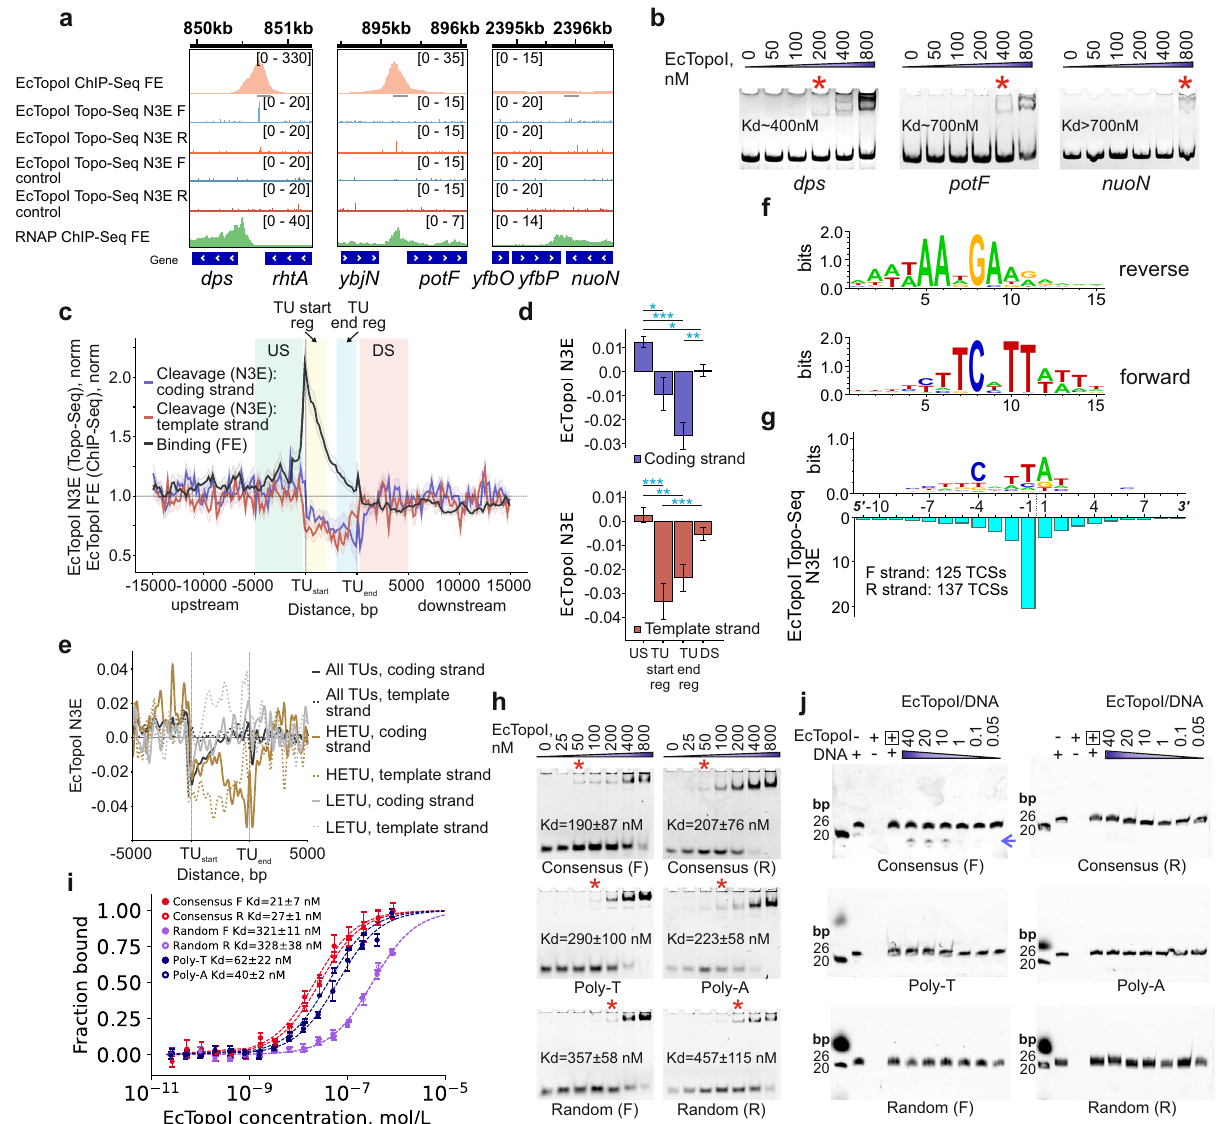
Fig. 4 | Topoisomerase I cleavage sites (TCSs) identi fi ed by Topo-Seq and sequence speci fi city of binding and cleavage. a Representative regions of the E. coli chromosome with EcTopoI ChIP-Seq peaks matching the EcTopoI Topo-Seq TCSs ( dps , potF ) and a region lacking EcTopoI-binding and activity ( nuoN ). EcTopoI cleavage activity is shown strand-speci fi cally. A control, non-induced culture, is shown. Positions of regions used for ChIP-qPCR and af fi nity measurements are indicated by gray rectangles. b Af fi nity of puri fi ed EcTopoI to three ampli fi ed genomicregionsfromthepanel a measuredbyEMSA.Redasterisksmarkthelowest concentration of EcTopoI at which a gel-shift was detected. c Metagene plot of EcTopoIChIP-Seqenrichment(untreatedcondition,blackcurve)andEcTopoITopo- Seq cleavage signal (blue and red curves for coding and template strands, respec- tively). Con fi dence bands around the mean metagene signal are represented by ±SEM. Analysis was performed for the HETU set. Regions used for further quanti fi - cation of enrichment in panel d are shown by colored areas on the plot. d Mean EcTopoI cleavage signal in different regions relative to HETUs. Means were com- pared by a two-sided Welch t -test. P values <4e-3 are indicated by asterisks